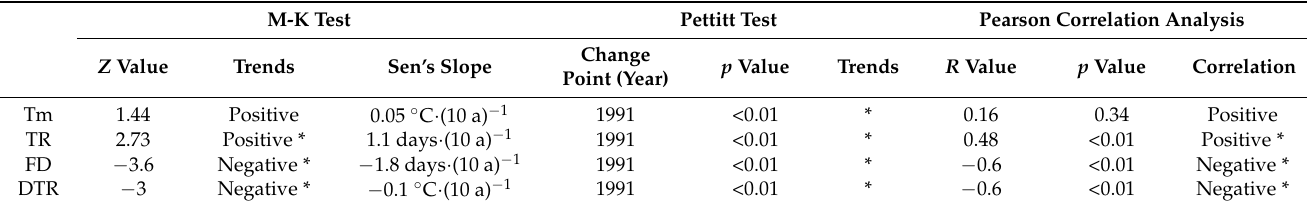
Table 3. The impact of urban expansion on temperature in Jinan City during the period of 1979–2017.